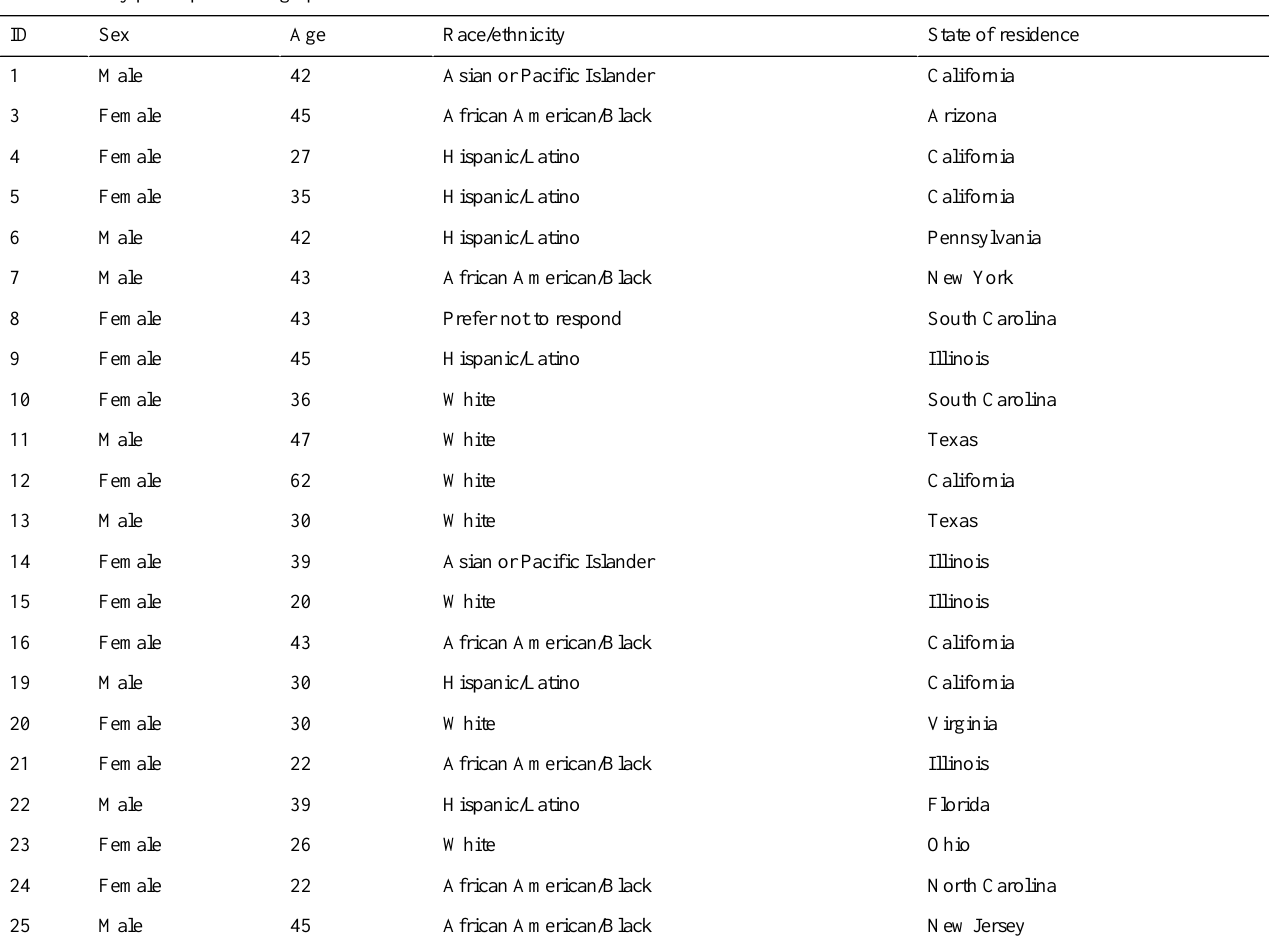
Table 1. Study participant demographics.